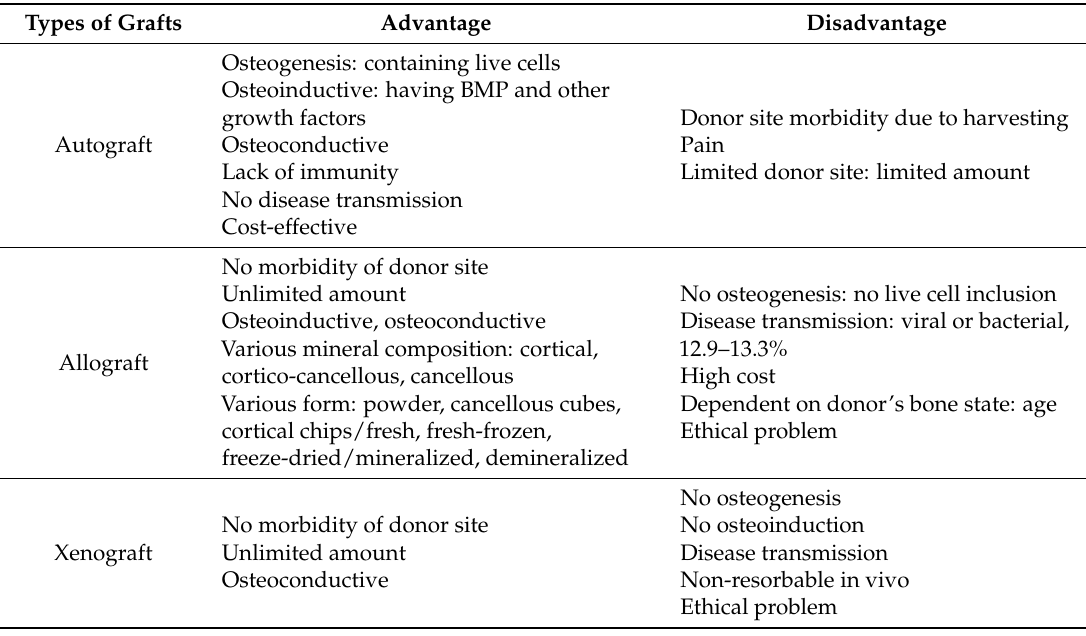
Table 1. Advantages and disadvantages according to the types of